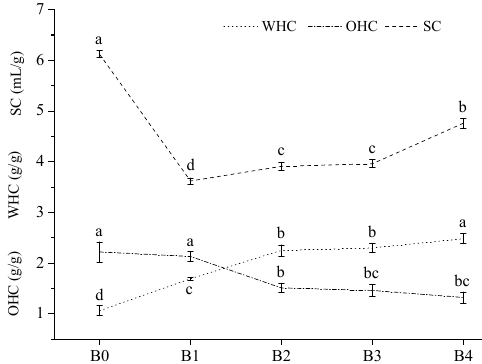
Figure 7. The water-holding capacity (WHC), oil-holding capacity (OHC), and swelling capacity (SC) of the wheat bran. The B0, B1, B2, B3, and B4 are the wheat bran prepared under the rolling frequencies 0, 6, 9, 12, and 15 times. Different lowercase letters on the shoulders of the same indicator indicate significant differences ( p < 0.05).